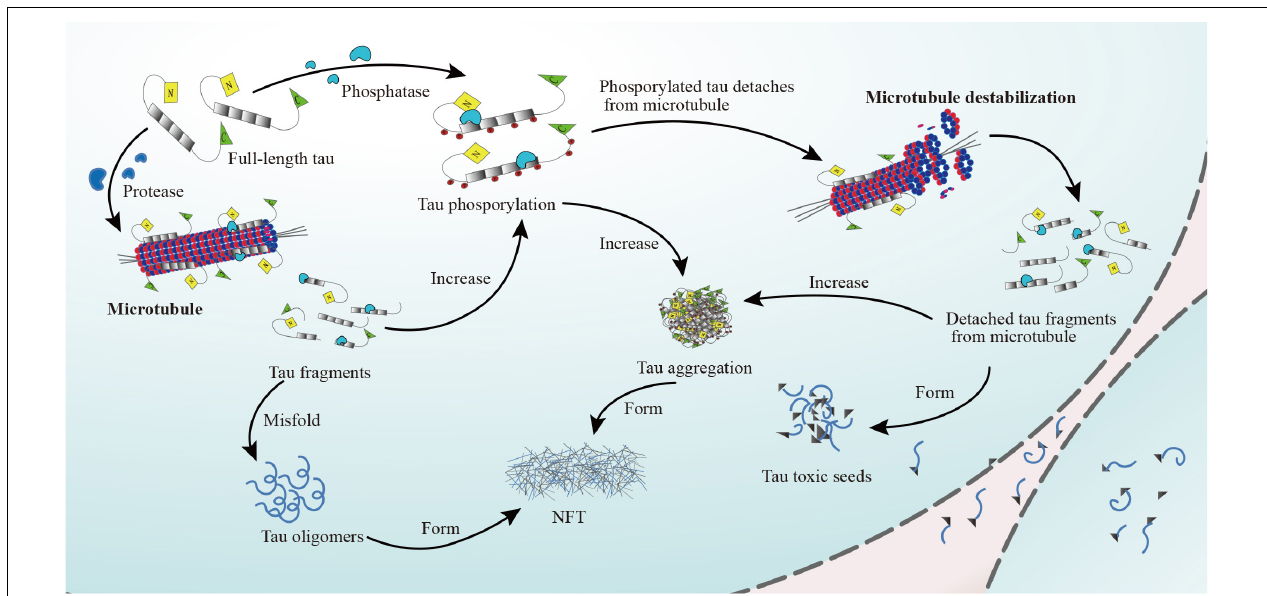
FIGURE 2 | Detachment of tau protein from MTs. The full-length tau protein binds to MTs, stabilizing them under the regulation of phosphatases (e.g., PP1, PP2A, PP2B, PP2C, and PP5). When tau protein phosphorylates, tau protein will detach from MTs. The microtubules will destabilize and dissociate. Detached tau fragments form tau aggregation, which ultimately leads to the formation of NFTs. At the same time, phosphorylated tau protein and detached tau fragments misfold and form tau oligomers, which are the precursors of NFTs, or toxic tau